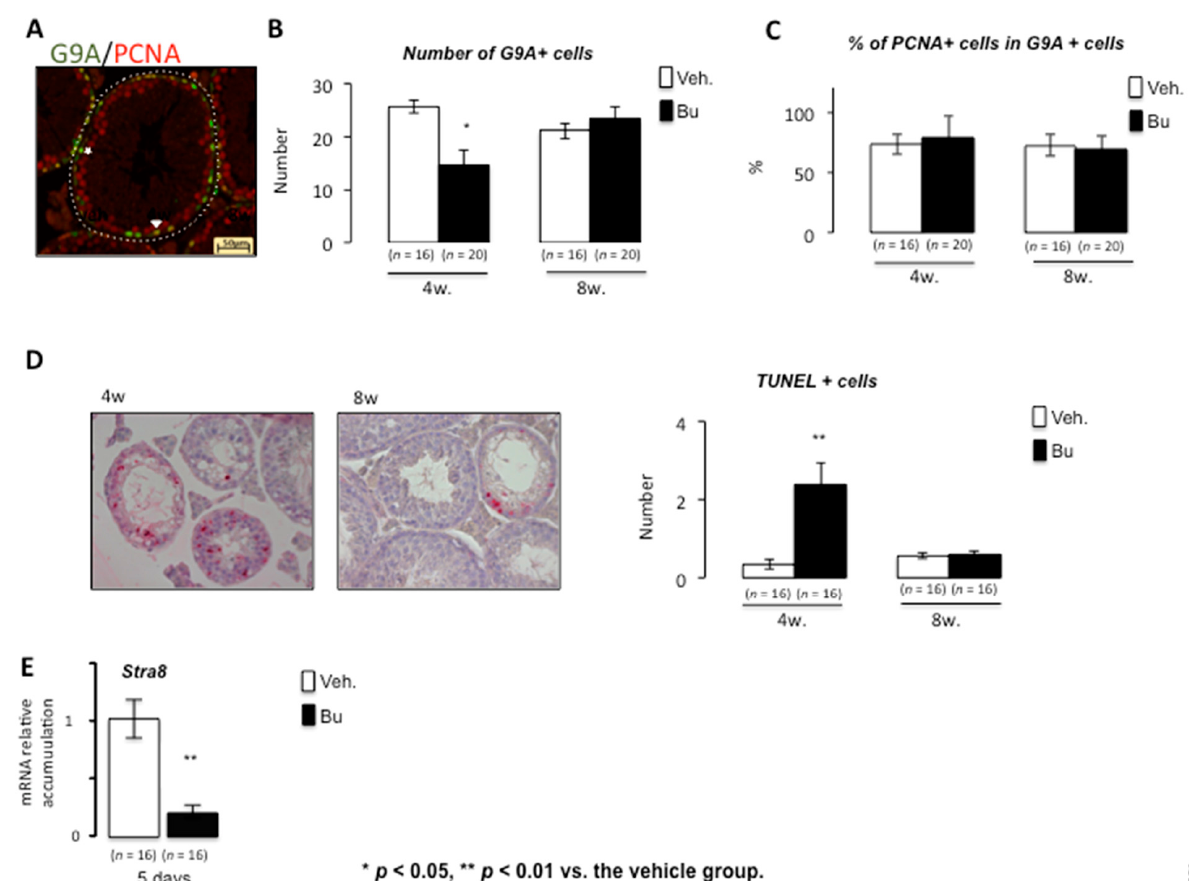
Figure 2. Acute busulfan exposure alters spermatogenesis and germ cell survival in male mice. ( A ) Representative micrograph of vehicle- or Bu-treated testis stained for G9A (green) and PCNA (red). The arrowhead indicates G9A/PCNA-positive cells, and the star indicates PCNA-negative and G9A-positive cells. ( B ) The number of G9A-positive cells per seminiferous tubules in testes treated with vehicle or busulfan (4 and 8 weeks after treatment). ( C ) The percentage of G9A-positive cells co-stained for PCNA in testes treated with vehicle or busulfan (4 and 8 weeks after treatment). ( D ) (Left) Representative micrograph of testes of vehicle- or Bu-treated males stained for TUNEL. (Right) The number of TUNEL-positive cells per seminiferous tubule of males treated with vehicle or busulfan (4 or 8 weeks after treatment). ( E ) Relative Stra8 mRNA accumulation normalized to β -actin on testis after exposure to vehicle or Bu after 5 days. For all panels, the data were obtained from at least three independent experiments; the number of animals per group is indicated in parentheses below the bars of the graphs. The data are expressed as the means ± SEM. Statistical analysis: * p <